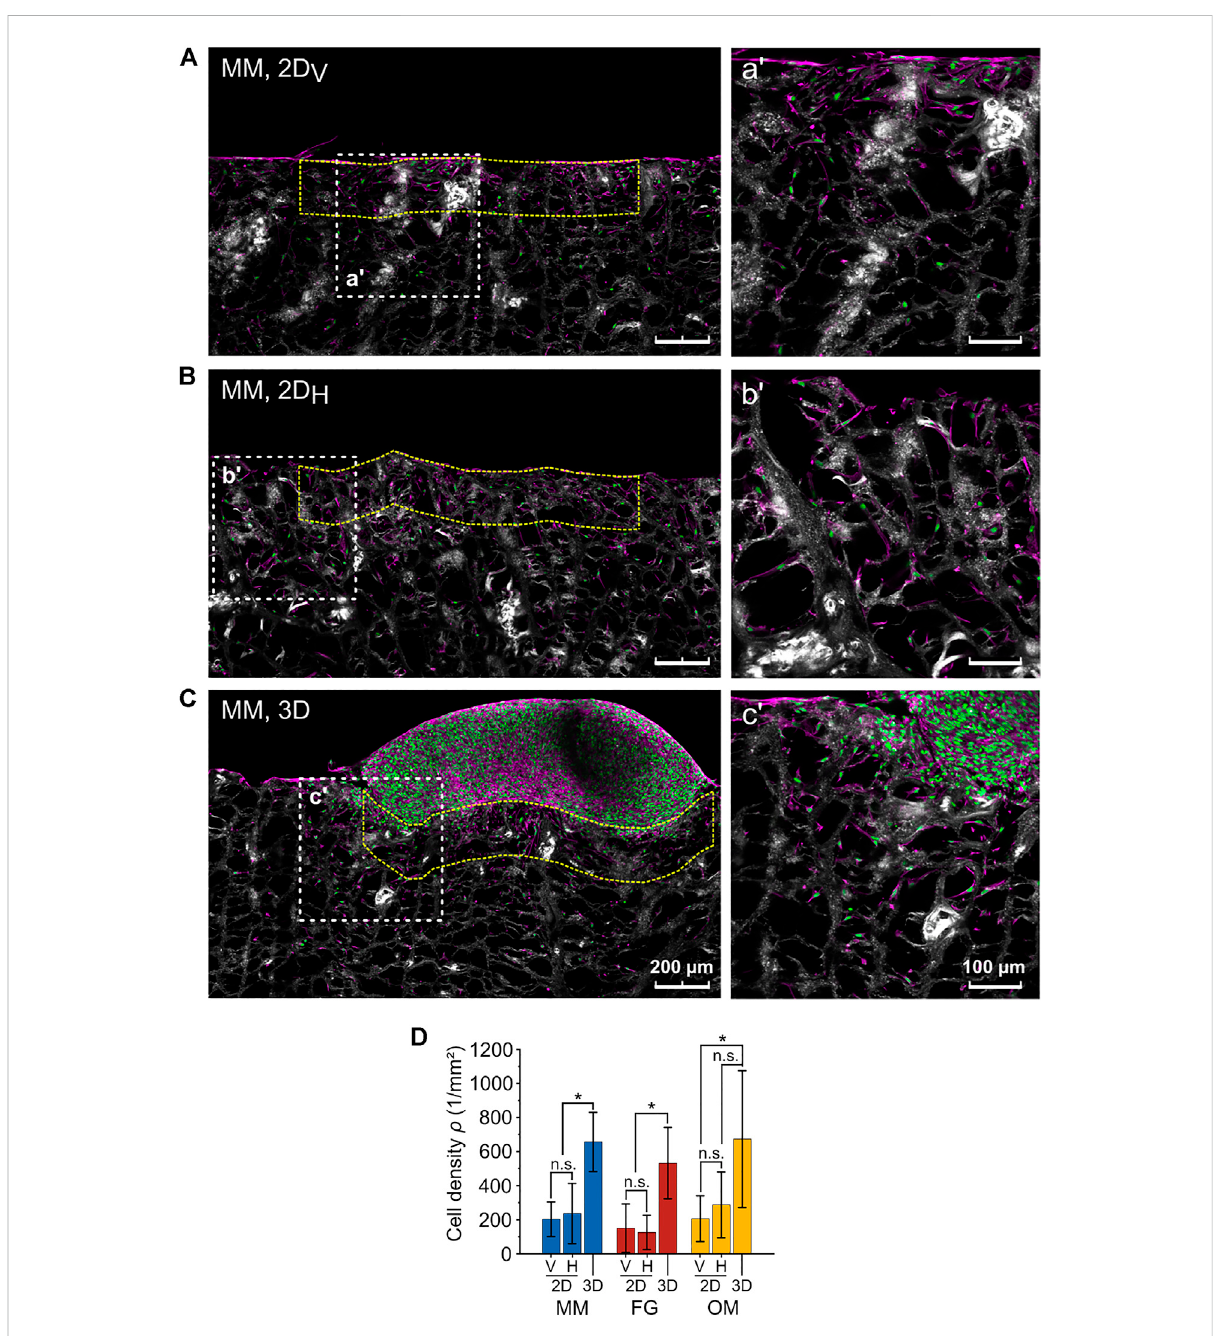
FIGURE 6 Difference in cellular density between the 2D layer assay and the 3D spheroid assay. (A – C) Representative images (maximum projections) of 2D V and 2D H layer and 3D spheroid assays, respectively (MM). Nuclei, F-actin, and collagen are shown in green, magenta, and white (second harmonicsignal),respectively.Thehighermagni fi cationimagesontheright(a ′ ,b ′ ,c ′ )showtheregionshighlightedbythewhitedashedlinesquares. The analyzed ROIs are exemplarily marked by dashed yellow lines. Scale bars are 200 µm for overviews and 100 µm for magni fi ed images; (D) cell densities as analyzed within the indicated ROIs in the 3D spheroid and 2D V and 2D H layer